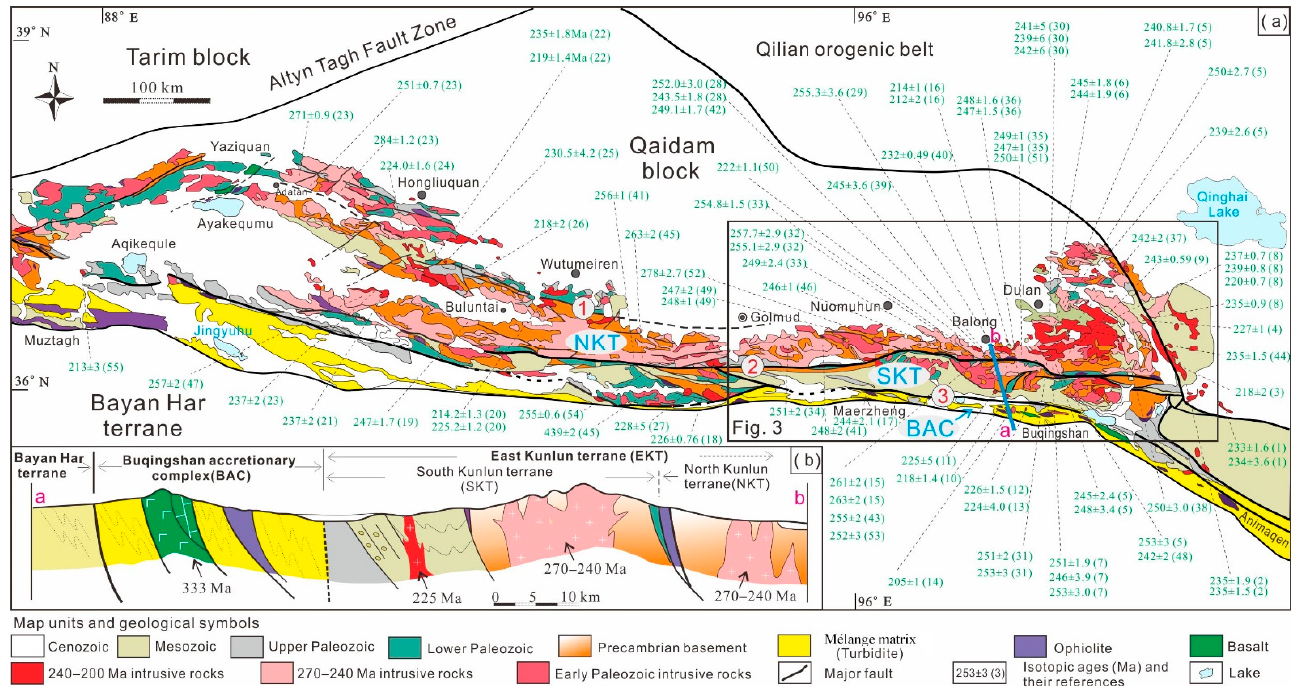
Figure 2. ( a ) Tectono-magmatic sketch map of the East Kunlun Orogen showing rock associations; ( b ) integrated cross section showing tectonic units and rock associations. The location of Figure 3 is outlined. ① —Qimatag–Xiangride fault; ② —Central fault of East Kunlun; ③ —South fault of East